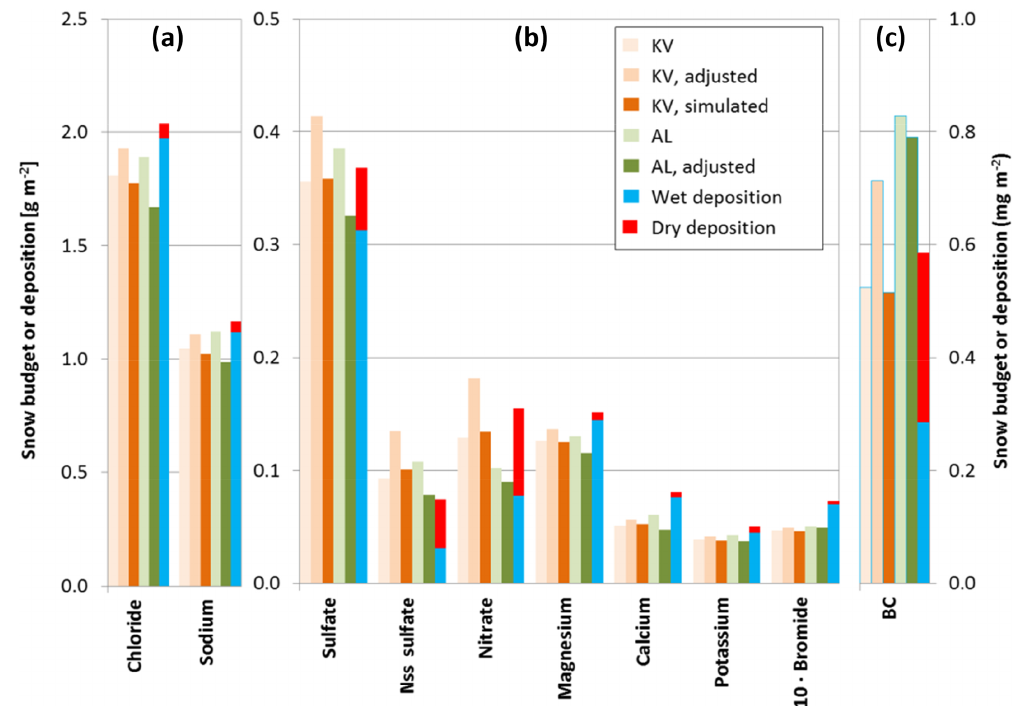
Figure 4. Snow budgets of sea salt components, nss sulfate, nitrate, bromide (a, b) , and BC (c) for the snow pits KV (Kongsvegen, orange) and AL (Austre Lovénbreen, green) for October 2011 to March 2012 according to different calculation methods: simple budgets from average concentrations and total SWE (light colors), adjusted budgets using colocated concentration and density profiles (middle colors), and simulated budgets for KV using interpolated concentration and simulated density profiles (dark colors). Also shown is the total deposition as the sum of observed wet deposition at Ny-Ålesund (blue) and estimated dry particle deposition (red). For bromide the wet deposition was estimated from the standard seawater ratio and all numbers are multiplied by 10. For BC the snow budgets correspond to rBC, while the wet deposition was estimated for the KV snow pit. The BC deposition corresponds to eBC. See text for further